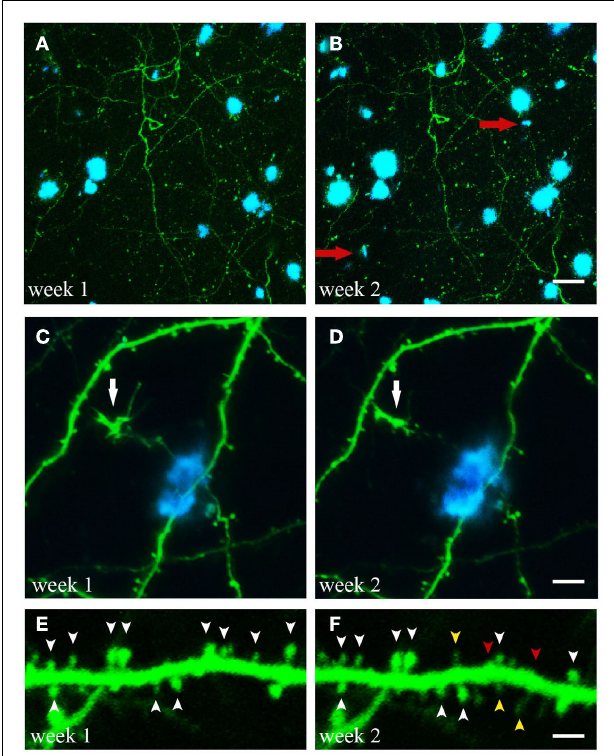
FIGURE 2 |Time-lapse imaging of structural alterations. (A,B) Maximum projections of z-stacks with GFP expressing neuronal structures and Methoxy-XO4 labeled amyloid plaques. Over the course of 1week two new plaques emerged within the region analyzed (marked with red arrows). (C,D) (White arrow). (E,F) Spine dynamics of an apical dendritic tuft (layerV pyramidal neuron of GFP-M mouse). Spines present at both imaging time points are indicated by white arrowheads, spines lost over the course of 1week are labeled with red arrowheads, spines newly formed during the same period are marked with yellow arrowheads. Scale bars represent 25 μ m (B) , 10 μ m (D) , and 2 μ m (F) ,